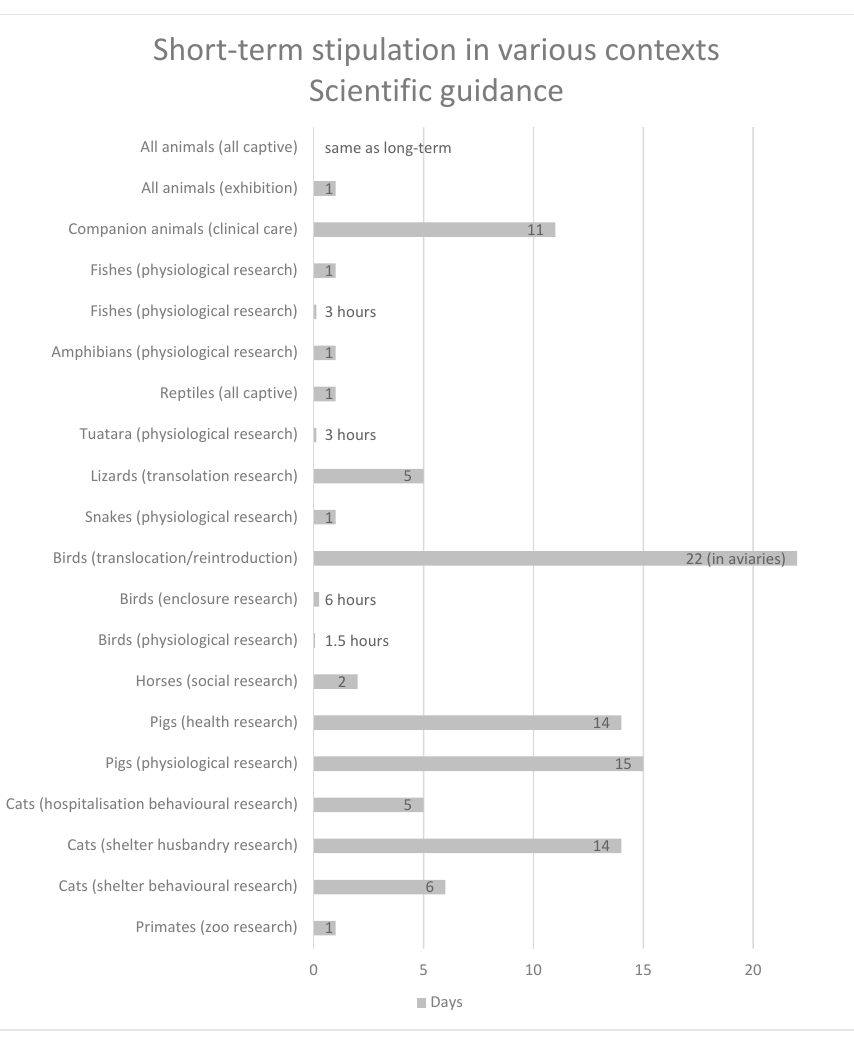
Figure 3. Comparative context for information contained in Table 2. (References [24–44]).